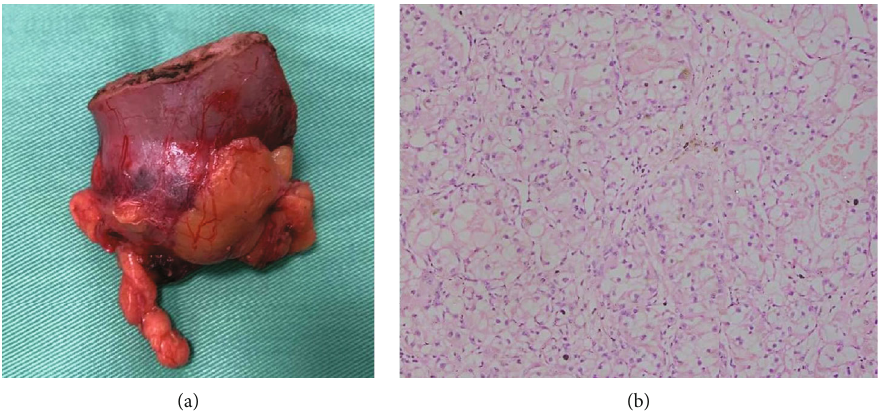
Figure 3: Left renal cell carcinoma. (a) Macroscopic appearance of the resected tumour. (b) Histology showing typical clear cell